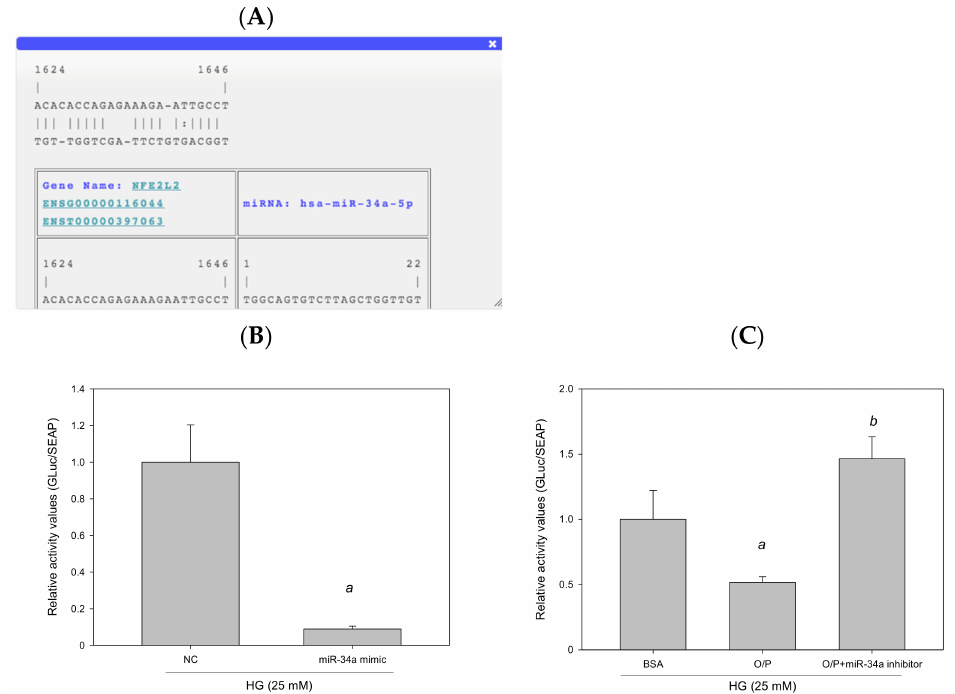
Figure 11. miR-34a-5p mediated cellular lipid accumulation by directly targeting NFE2L2 in HepG2 cells. ( A ) A potential interacting site in the human NFE2L2 was predicted by RNA22. ( B , C ) Luciferase reporter plasmids (1 µ g) containing the wild type of human NFE2L2 were cotransfected with 40 nM control mimic (NC), 40 nM hsa-miR-34a-5p, 20 pM control inhibitor (O/P), and 20 pM miR-34a-5p inhibitor into HepG2 cells plated in 12-well plates. After 24 h, luciferase activity was measured using the Secrete-Pair Gaussia Luciferase Assay Kit. a, p < 0.05 compared with the normal control group (NC or BSA group). b, p < 0.05 compared with the HG + O/P